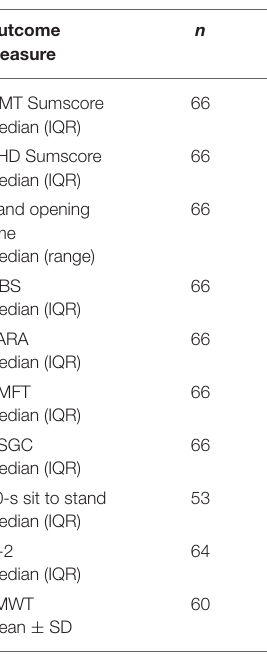
TABLE 2 | Comparison of results between V0 and